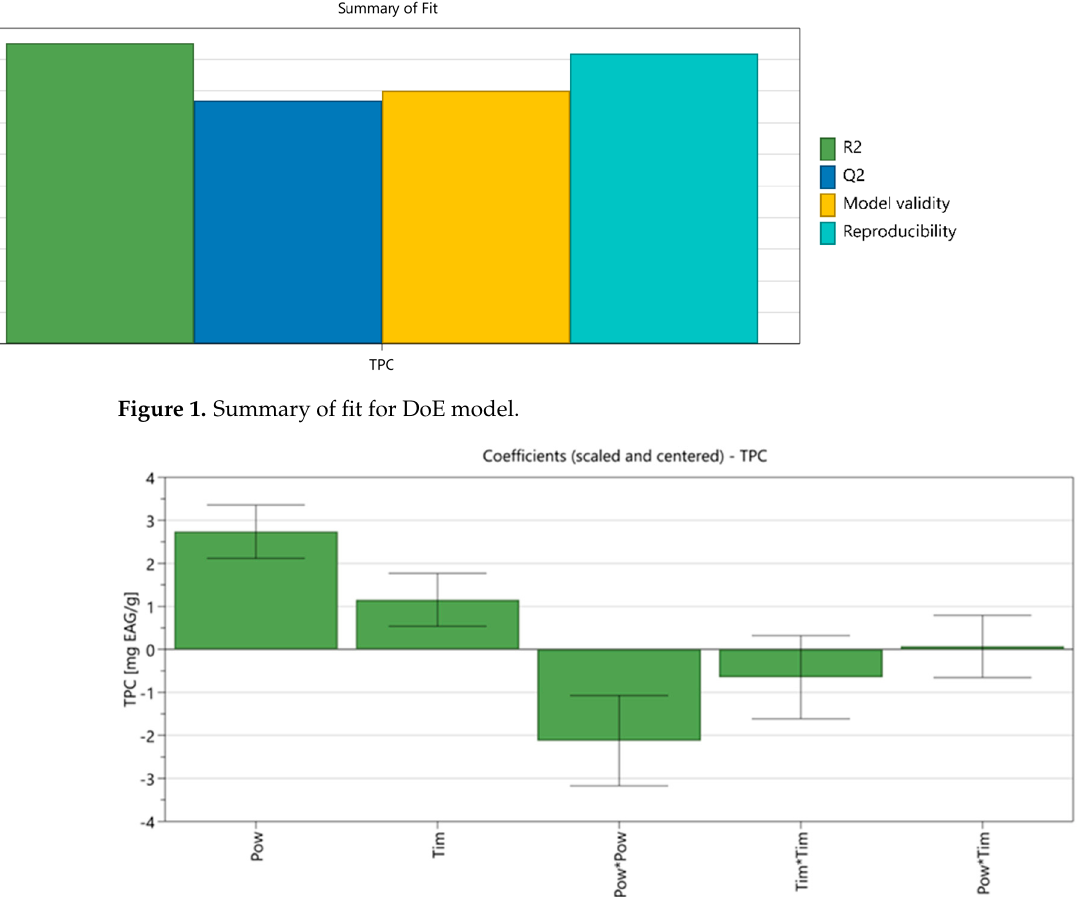
Figure 2. Scaled and centered coefficient plot.